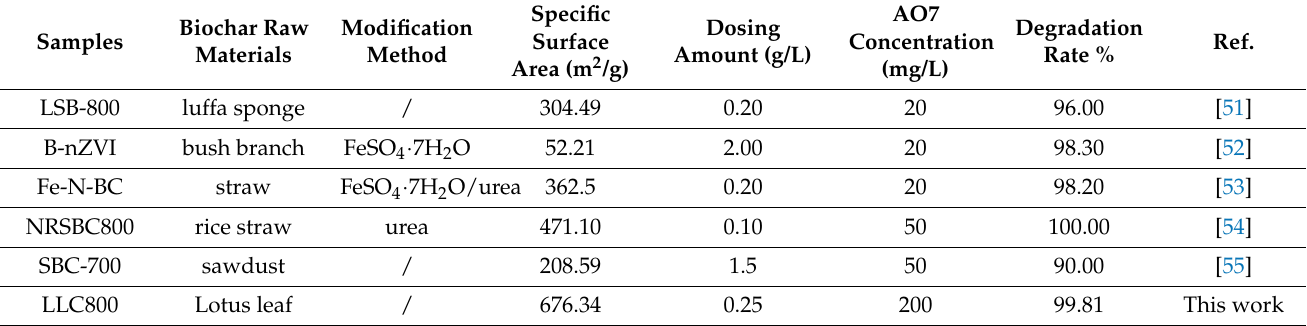
Table 2. Comparison of AO7 removal effect with other biochar.